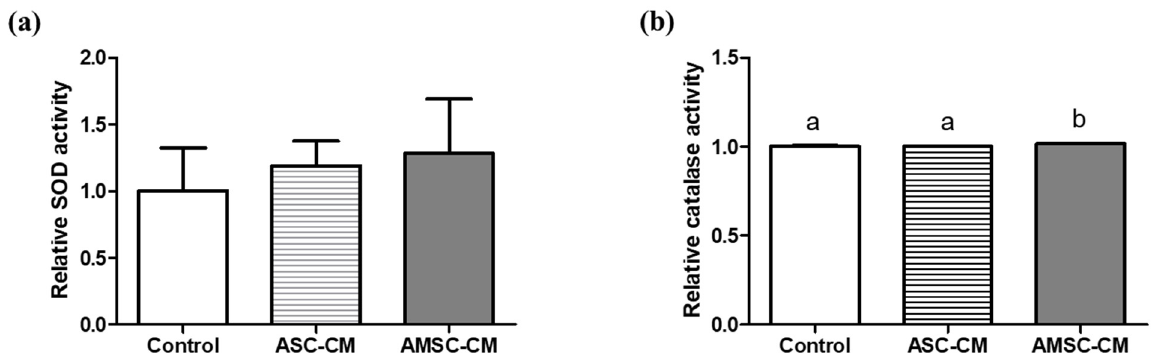
Figure 5. Comparison of antioxidant biomarkers level in fresh culture medium supplemented with human adipose-derived mesenchymal stem cell conditioned medium (ASC-CM) and amniotic membrane-derived mesenchymal stem cell conditioned medium (AMSC-CM). ( a ) Superoxide dismutase (SOD) and ( b ) catalase activity. Data are normalized to average value of control and presented as the mean ± SEM. Superscript letters in each column indicate significant differences ( p < 0.05).